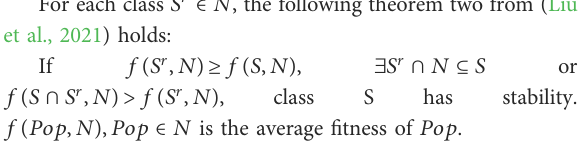
Table 1 ii. Crossover: New individuals are generated by performing nonuniform arithmetical crossover on the selected parents, as shown in Eq. 3. iii. Mutation: The Gauss-r.